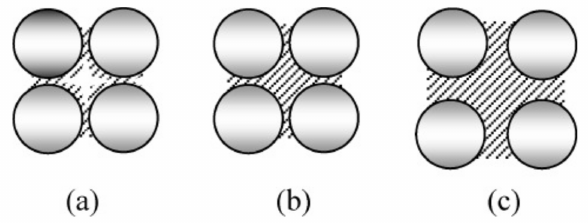
Figure 12. Schematic illustration of the effect of increasing molarity levels on the formation of geopolymeric binder around FA particles, in accordance with the mechanism proposed by Fansuri et al.: ( a ) insufficient amount of binder that incorporates FA particles due to low molarity condi- tion, ( b ) optimal condition in terms of alkaline activator molarity and microstructural quality, and ( c ) excessive molarity level and consequent inhibition of the precursor activation. Reprinted with permission from Ref. [56]. Copyright 2010 Wiley.